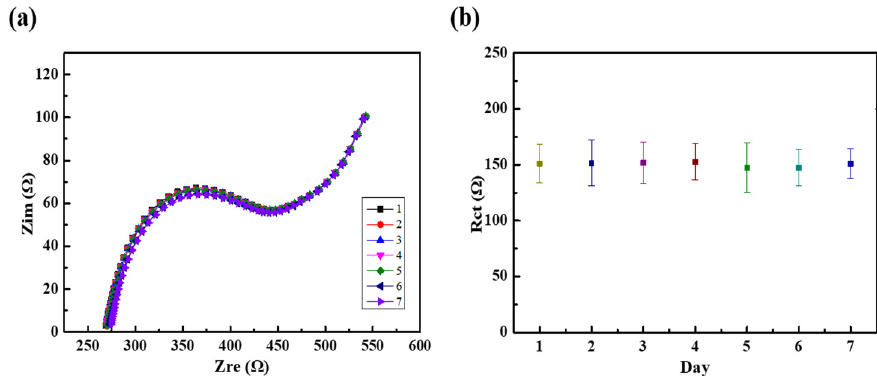
Figure 9. ( a ) Nyquist plots and ( b ) R ct values for 1 nM probe DNA and target 1 DNA measured every 24 h for 7 days in 4 mM [Fe(CN) 6 ] 3 − /4 − solution with 1 × PBS buffer (pH =